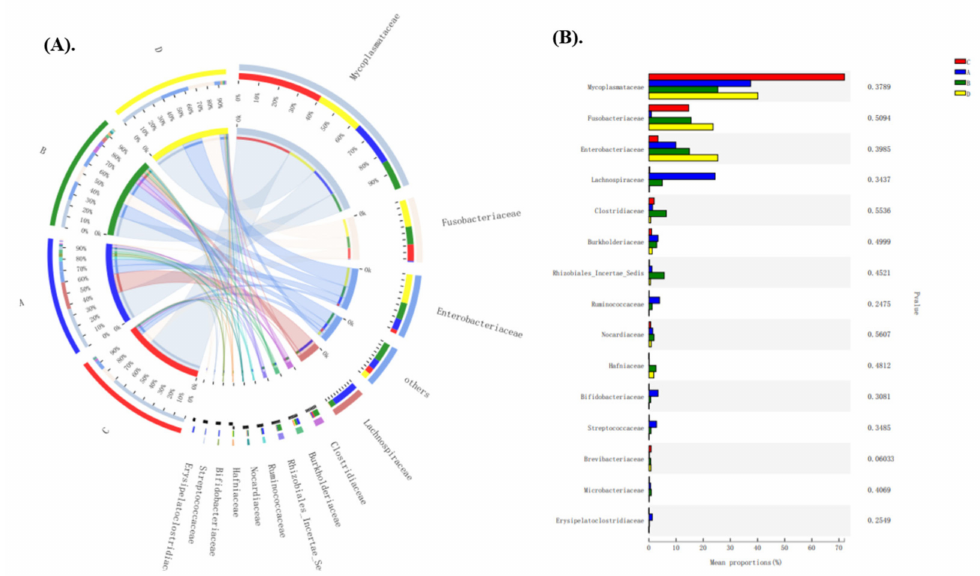
Figure 6. Bacterial compositions of the different communities ( A ) and results of the Kruskal–Wallis test for differences in these microbial taxa ( B ) among each group at the genus level.